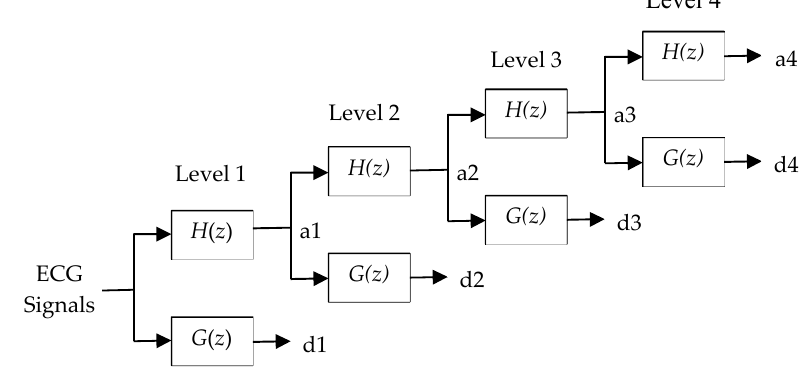
Figure 4. A four-level dyadic wavelet transform of ECG signals using a two-channel filter bank.